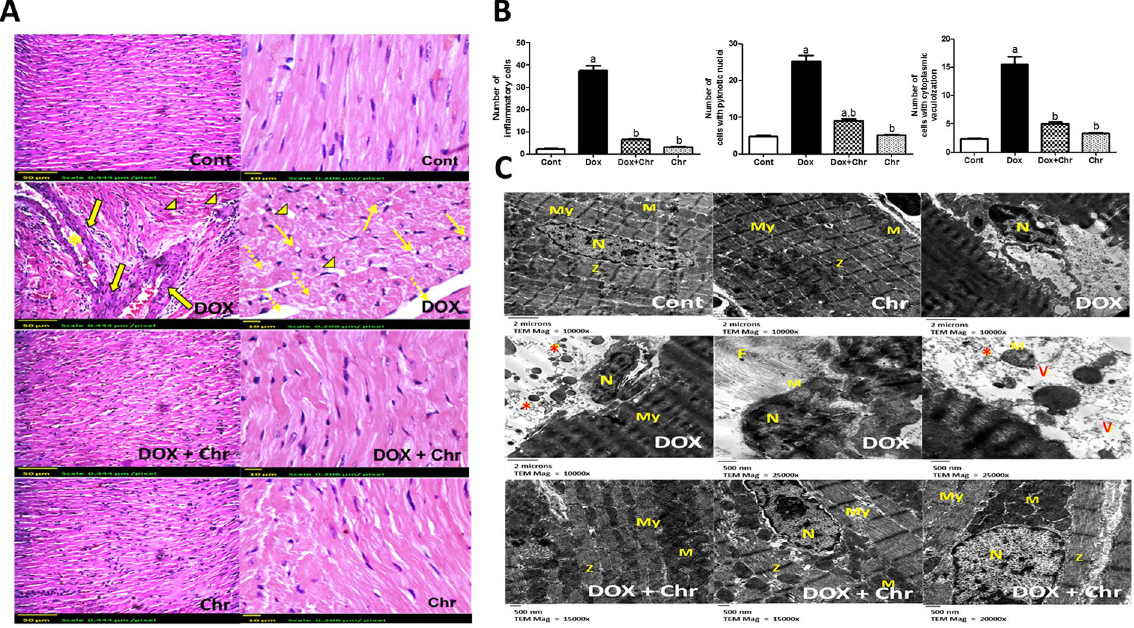
Figure 2. Effect of chrysin on histopathological alterations in rats subjected to chronic doxorubicin (DOX) intoxication. ( A ) Photomicrographs of heart sections stained by H & E, (arrows) pyknotic nuclei, (dotted arrows): myofibrillar loss, (arrowheads): cytoplasmic vacuolization, (solid arrows): inflammatory cell infiltration and (star): congestion. Scale bar, 50 µ m (200x) and 10 µ m (400x). ( B ) The mean number of inflammatory cells, cells with pyknotic nuclei and cells with cytoplasmic vacuolization in different treated groups. The measurements were done in 4 non overlapping fields in each of 5 different sections taken from 5 different animals of each group. Data are represented as mean ± SD (n = 10). a or b: Statistically significant from the control or DOX group respectively at P < 0.05 using one-way analysis of variance ANOVA followed by Tukey-Kramer as a post-hoc test. ( C ) Electronmicrographs of ultrathin sections of heart observed by transmission electron microscopy, (My): myofibril (M): mitochondria, (N): nucleus, (F): fibrosis, (asterisk): damaged mitochondria and (v): vacuoles. Scale bar, 2 µ m (10000x) & 500 nm (15000, 20000 &